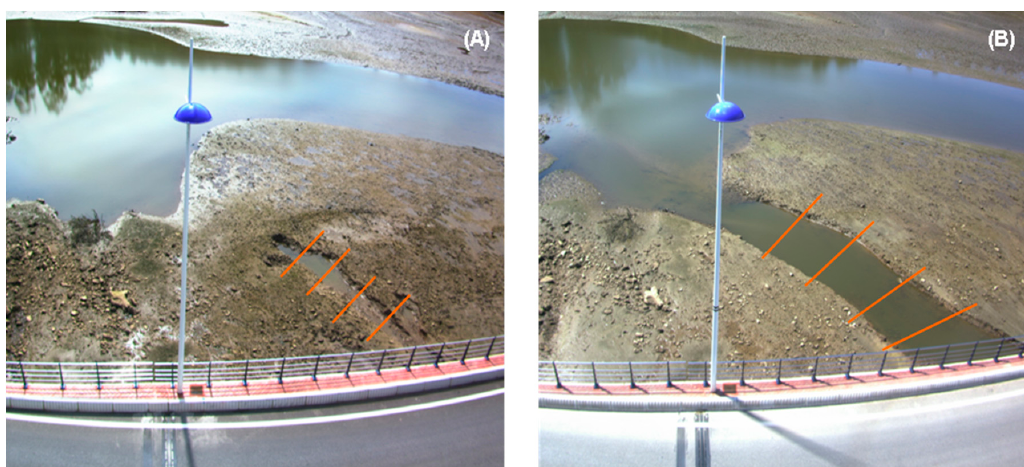
Figure 11. Selected transects. ( a ) Initial location of the transects (15/8/2010). ( b ) Location of the transects after a year (31/8/2011).